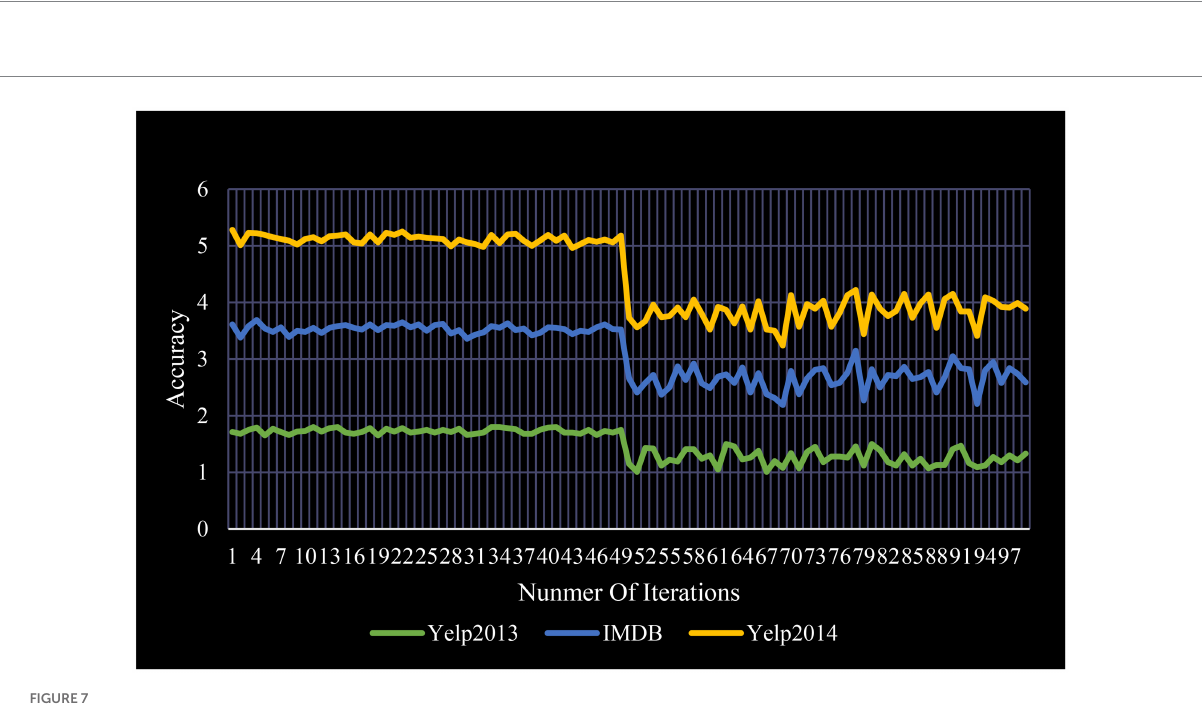
FIGURE 7 Accuracy